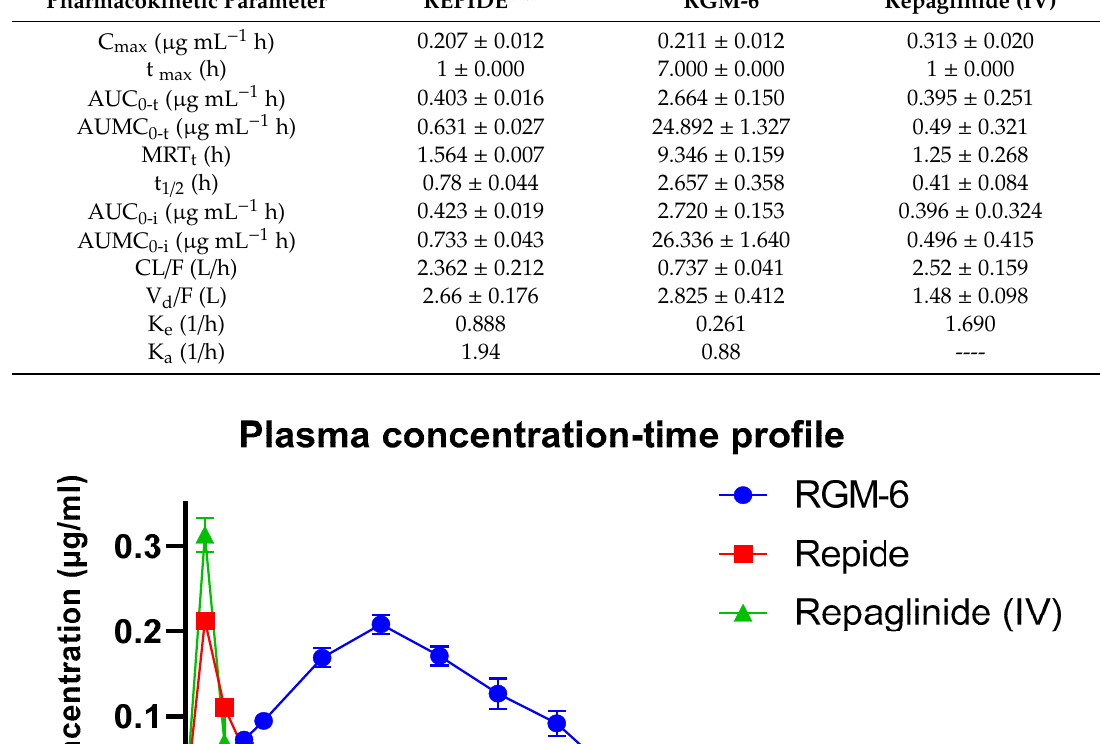
Table 5. Pharmacokinetic parameters for marketed (Repide) and test (RGM-6) formulations.